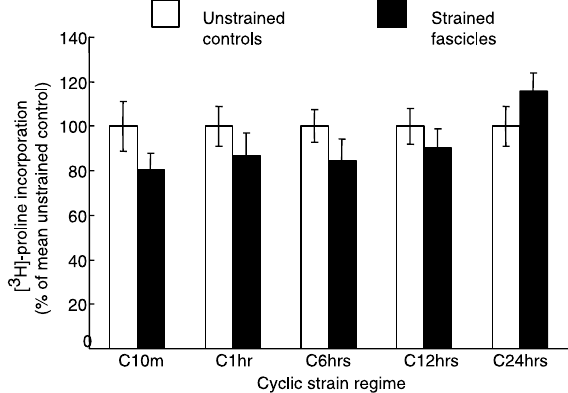
Fig. 4 E ff ect of total duty strain cycles on the mean of [ 3 H]proline incorporation ratio within the matrix of strained fascicles to unstrained control fascicles. C10m, C1hr, C6hrs and C24hrs represent data of our previous experiment which provided di ff erent numbers of strain cycles to fascicles in a continuous manner (7) . C12hrs represents the data of I12hrs obtained in the present study as this regime provided 43,200 strain cycles continuously during 12 hours. Mean ±